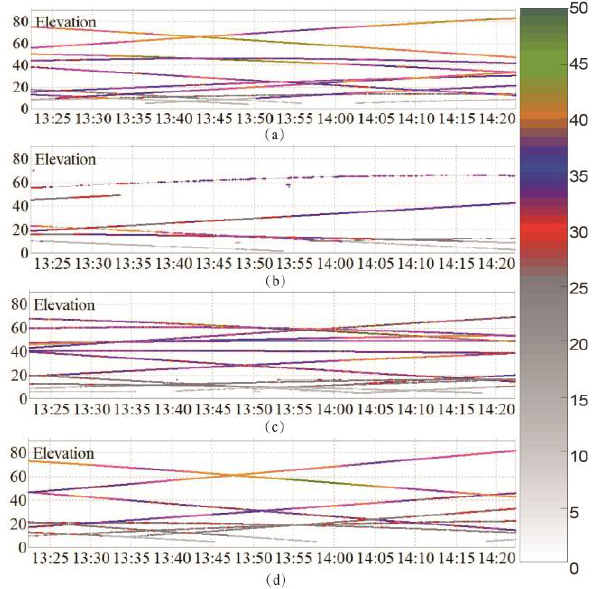
Figure 4 . The variation trend of C/N0 of GPS, Galileo, BDS, and GLONASS at different times and elevation angles. (a) is the variation trend of C/N0 of GPS. (b) is the variation trend of C/N0 of Galileo. (c) is the variation trend of C/N0 of BDS. (d) is the variation trend of C/N0 of GLONASS. The colour bar indicates the level of the C/N0 value.